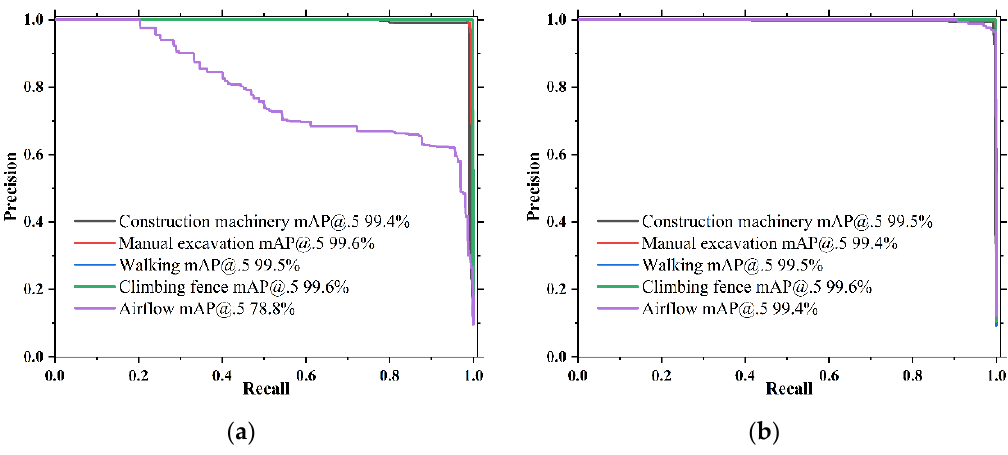
Figure 8. Training loss and validation loss of different models: ( a ) Training loss of six experimental models; ( b ) Validation loss of six experimental models.